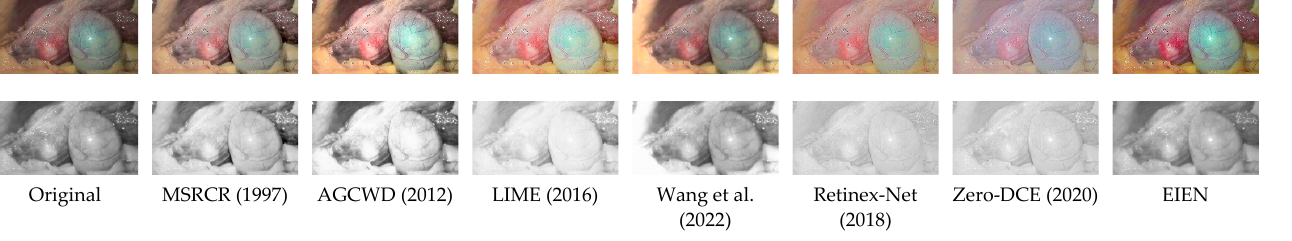
Figure 1. An example of image enhancement by different algorithms. The first row is the result of image enhancement, and the second row is the illumination component of the enhanced image, where the illuminance component is derived from our decomposition network. The figure shows that the enhancement results of other algorithms show over-enhancement or smoothing, while the image enhanced by EIEN has rich details [6,9,11,12,14,16].